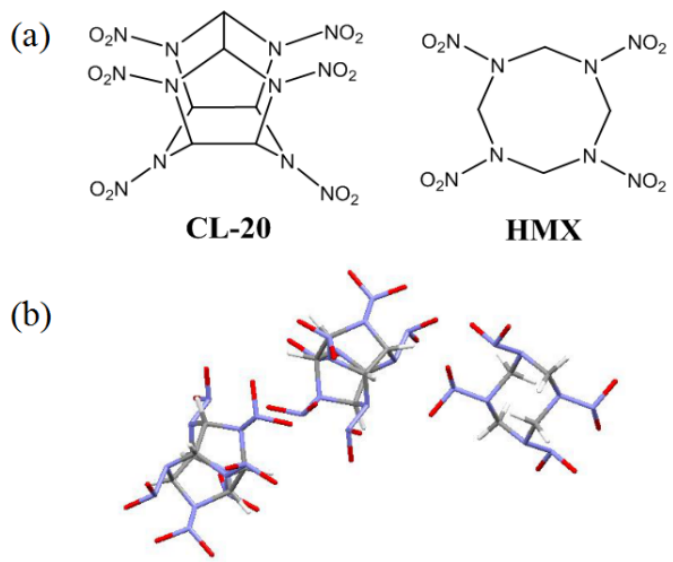
Figure 1. The molecular structures of ( a ) CL-20 and HMX; ( b ) 2:1 CL-20:HMX cocrystals.